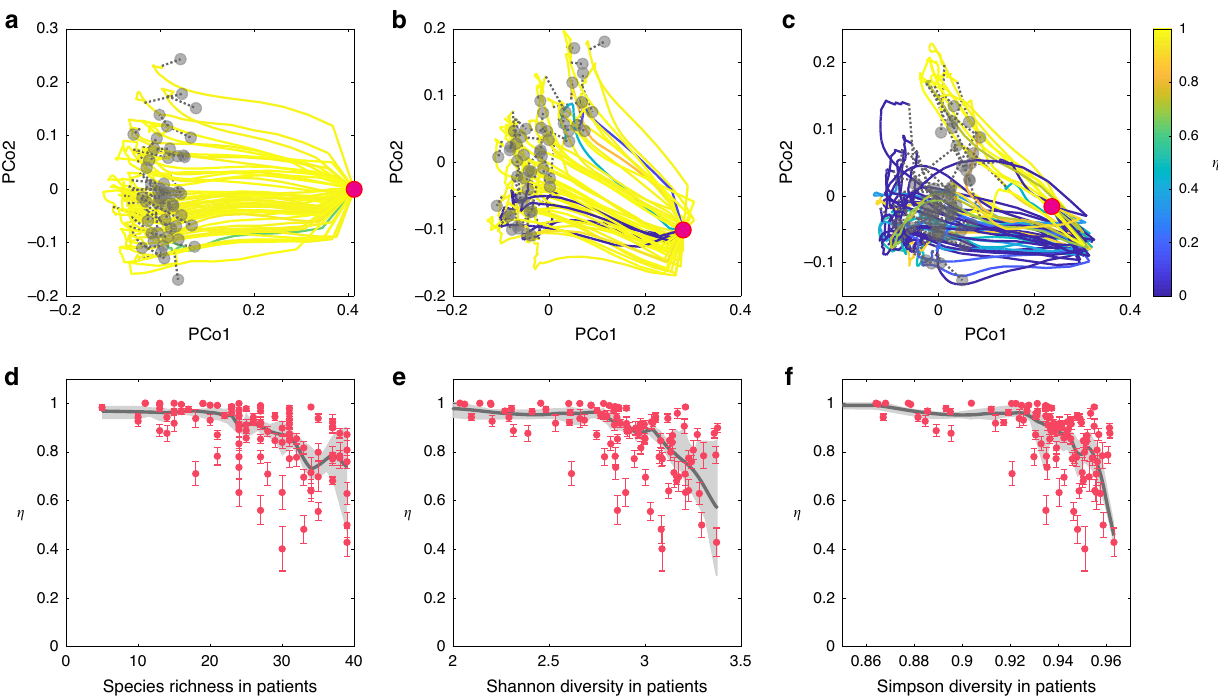
Fig. 4 Impact of taxonomic diversity of recipient ’ s pre-FMT microbiota on FMT ef fi cacy. We simulate the FMT processes with universal microbial dynamics. Species in the gut microbiota of 50 healthy donors are randomly chosen from a pool of 100 species with the only condition that C. dif fi cile cannot colonize. The healthy microbiota of those donors (represented by the gray dots in the PCoA plot) contains 60 − 80 species. a – c The recipient ’ s pre-FMT microbiota (represented by the red dot in the PCoA plot) has 12 ( a ), 22 ( b ), and 31 ( c ) species, respectively. For each case, we visualize the time series data of species abundances as trajectories in the PCoA plot, with trajectory color representing the recovery degree evaluated after the recipient ’ s gut microbiota reaches steady state. d – f The taxonomic diversity of 100 recipients ’ pre-FMT microbiota (quanti fi ed by three indices: species richness ( d ), Shannon diversity ( e ), and Simpson diversity ( f )) strong affects the FMT ef fi cacy (quanti fi ed by the recovery degree). We performed nonparametric regression and bootstrap sampling to calculate the trend (black line) and its 94% con fi dence interval (gray shadow). The error bar represents the standard error of the mean (SEM) calculated from 50 independent FMT simulations. See Supplementary Note 1 for details on the model parameters used in the FMT